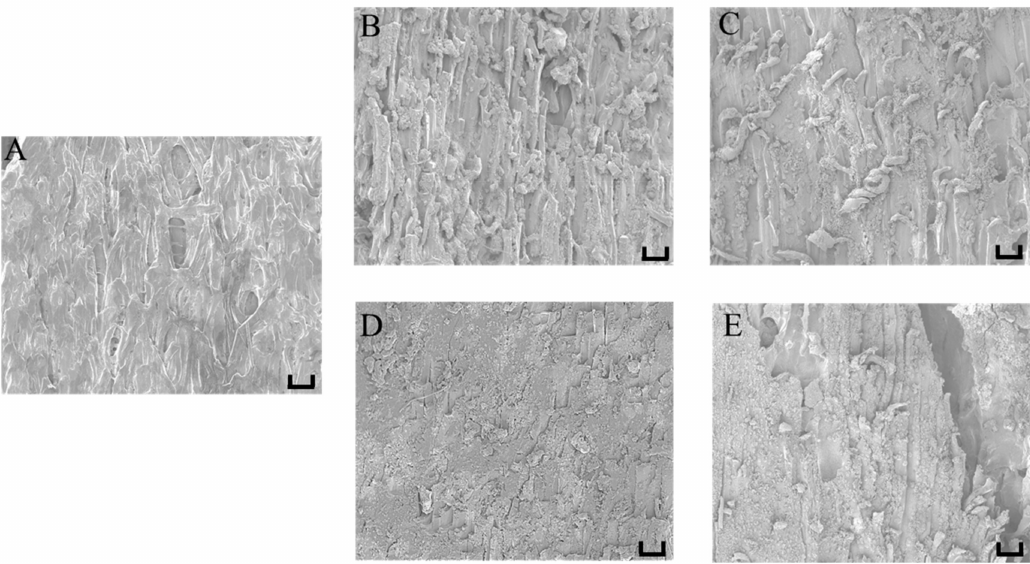
Figure 4. Effect of moisture content on the microstructure of fish filet samples by SEM images (50 × ). ( A ) fresh, the fish filets fried to ( B ) 65%, ( C ) 60%, ( D ) 55%, ( E ) 50% moisture content. Scale bar = 100 µ